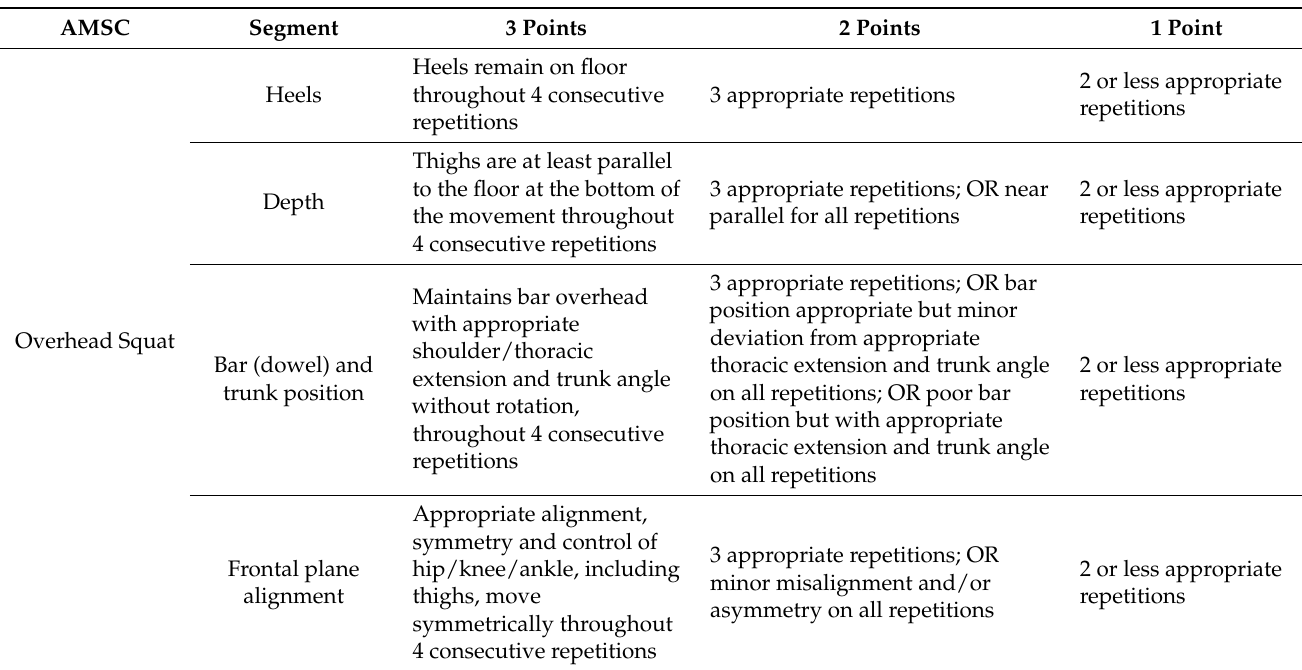
Table 2. Segmental performance criteria adapted from the Athlete Introductory Movement Screen (AIMS)